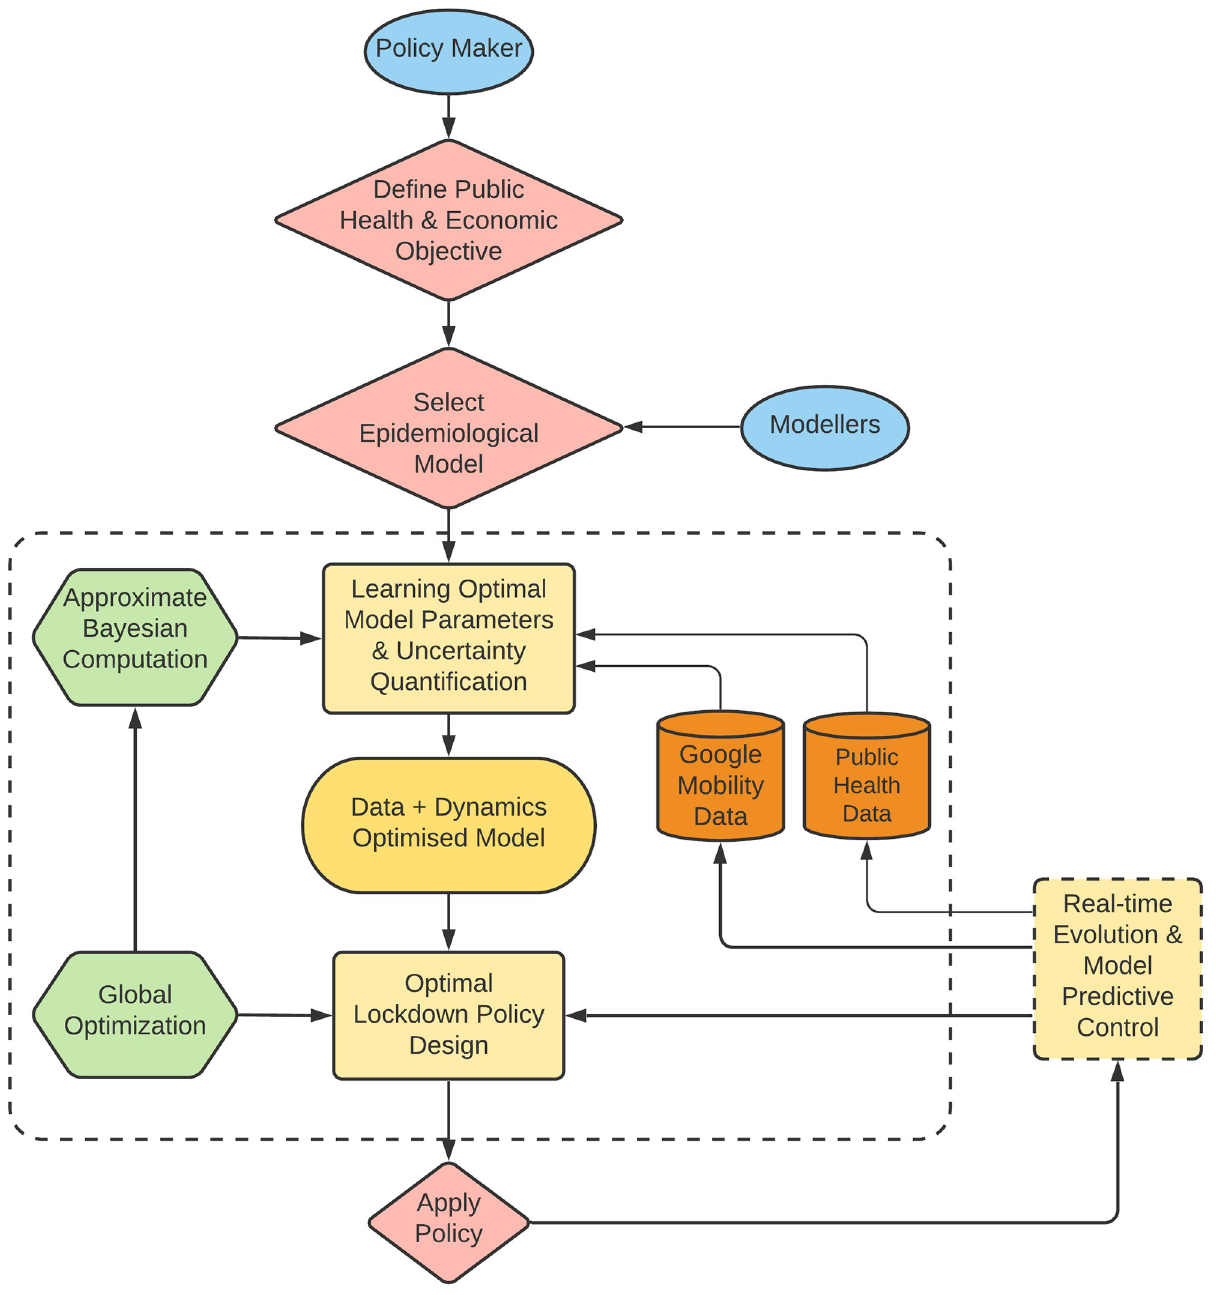
Fig 1. Flow diagram of the data-driven approach for the synthesis of optimal lockdown policies. The initial step consists of a policy maker defining a performance measure based on sanitary and economic objectives, and a modeller selecting a consistent generic epidemiological model. Then, public healthcare/mobility data is used in conjunction with Approximate Bayesian Computation to calibrate the dynamical model and determine the degree of uncertainty in the model parameters. This assists the formulation of an optimal control problem where the original sanitary + economic performance measure is optimized constrained to the calibrated epidemiological model. An optimal lockdown policy is then computed via global optimization techniques, and the final output is an optimal lockdown policy. The optimised lockdown is then applied and its real-time effects can be sensed through public data, which fed back into the learning and optimization framework for re-computation and